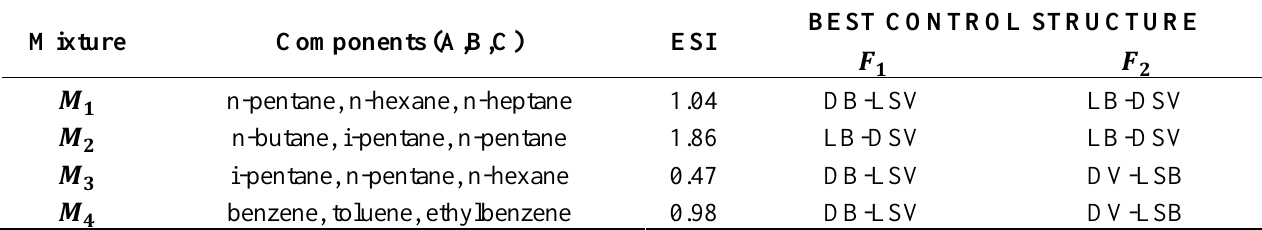
Table 6. Best control structures for the case studies.